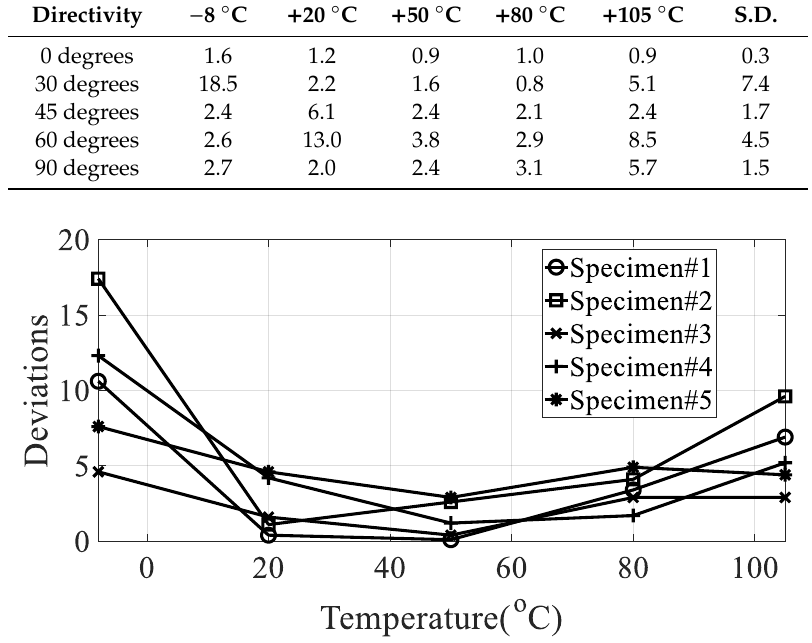
Figure 10. Deviation of the resonance frequency from the mean value according to different temperature conditions.